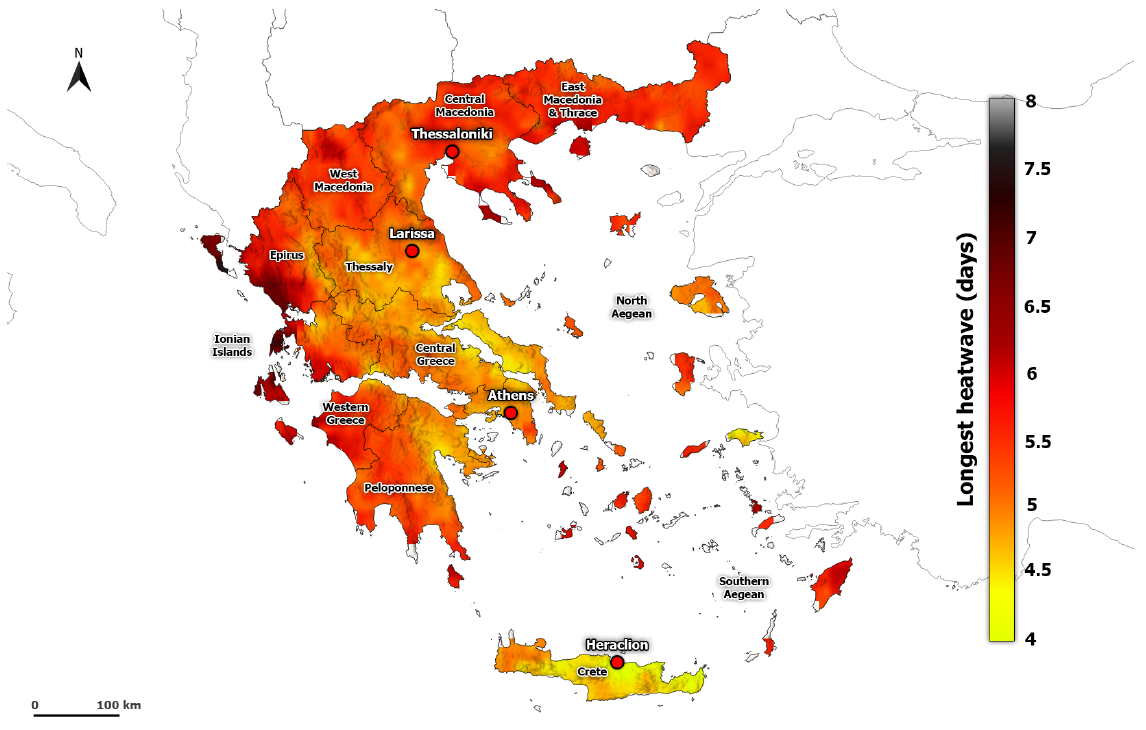
Figure 4. Spatial distribution of averaged HWD (days) based on all heatwave events calculated from ERA5-Land during the period 1950–2020.